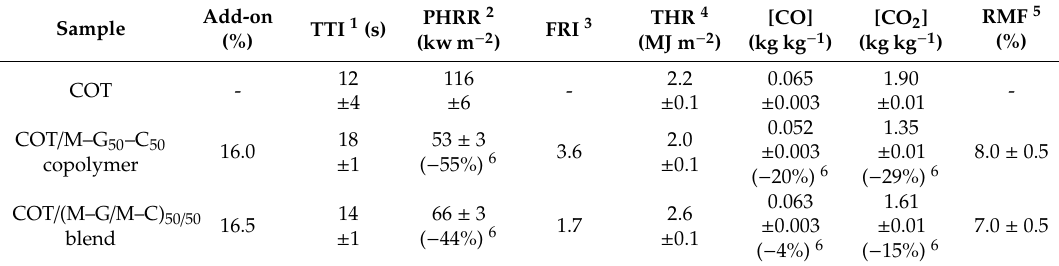
Table 7. Combustion data of untreated and cotton fabrics treated with M–G 50 –C 50 copolymer and (M–G / M–C) 50 / 50 blend by cone calorimetry